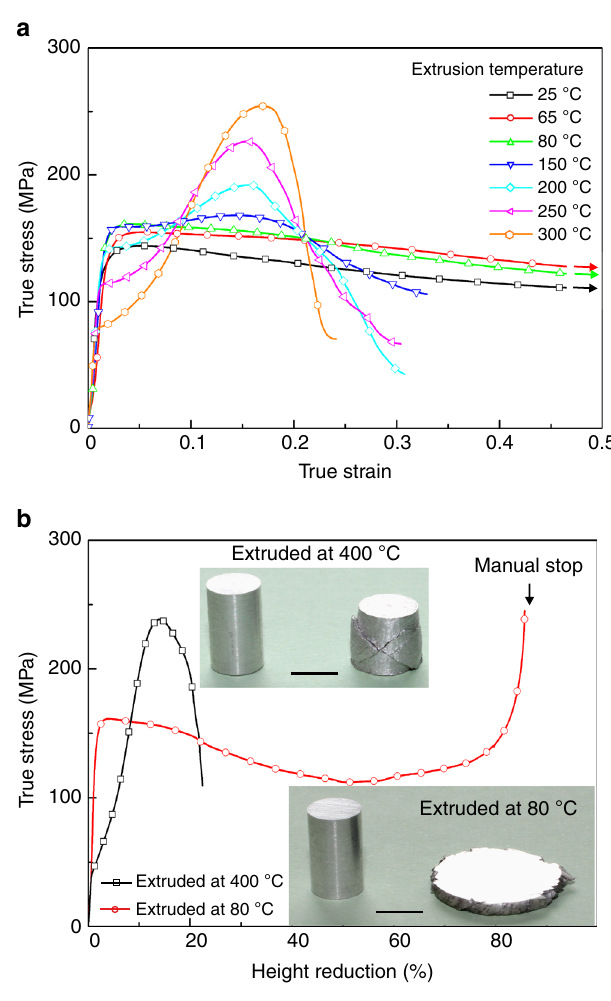
Fig. 1 Cold compression of extruded specimens. a Room temperature compressive true stress-strain curves of specimens extruded a in the temperature range 25 – 300 °C. b Room temperature compression of specimens extruded at 80 and 400 °C. Photo insets show the specimens before and after compression test. Scale bars in photo insets indicate 5